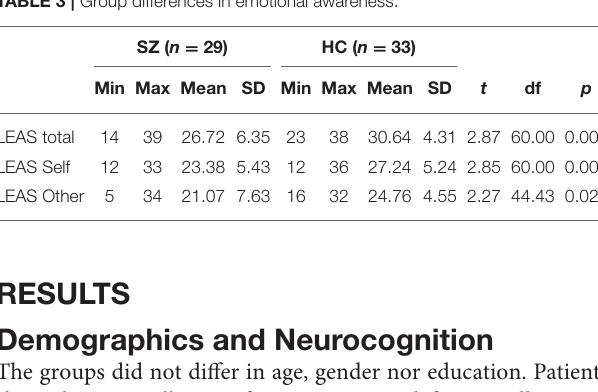
TABLE 3 | Group differences in emotional